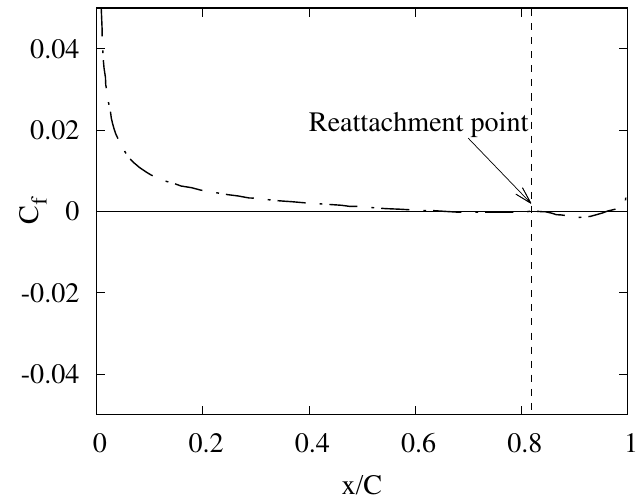
Figure 14. Averaged friction coefficients on the suction side of NACA0012